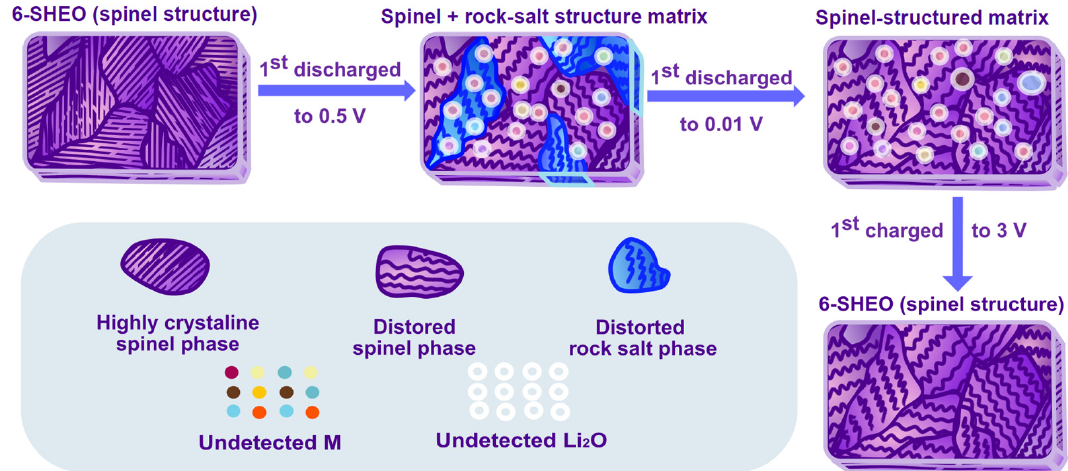
Figure 7. Illustration for lithium storage mechanism of the 6-SHEO anode.